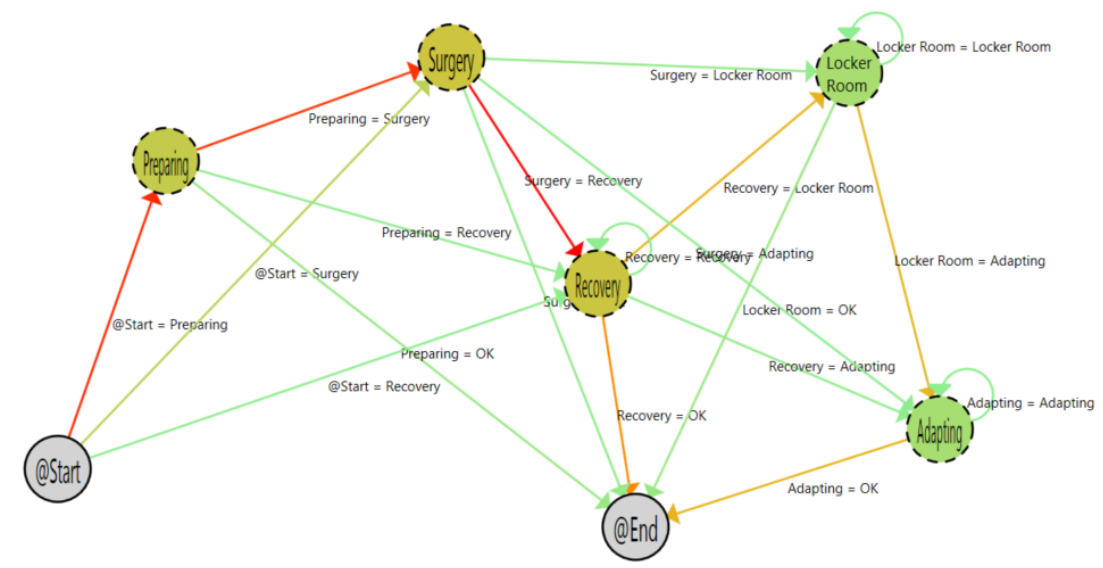
Figure 10. Outpatient process samples.